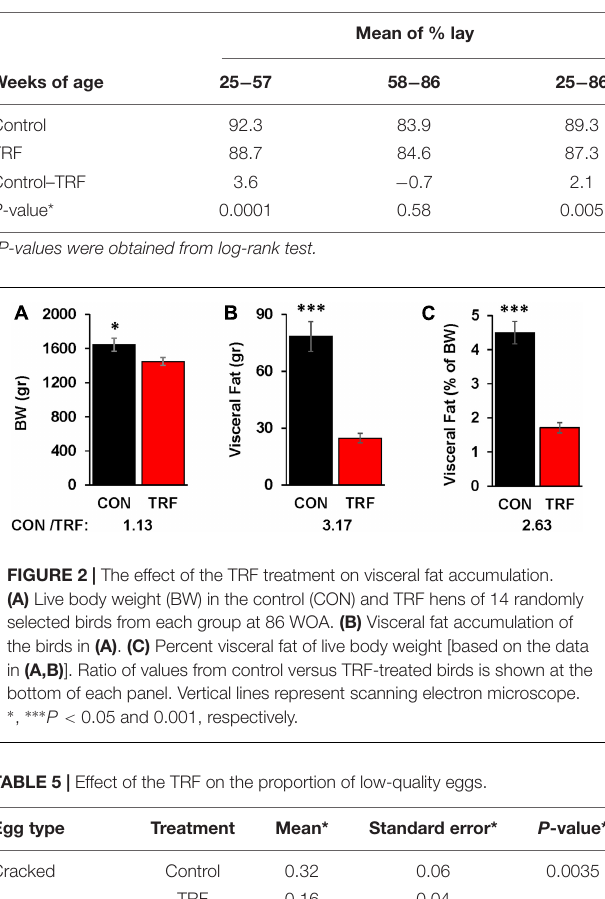
TABLE 4 | Dynamic changes in comparative laying efficiency between the TRF and control chickens, calculated per hen housed.